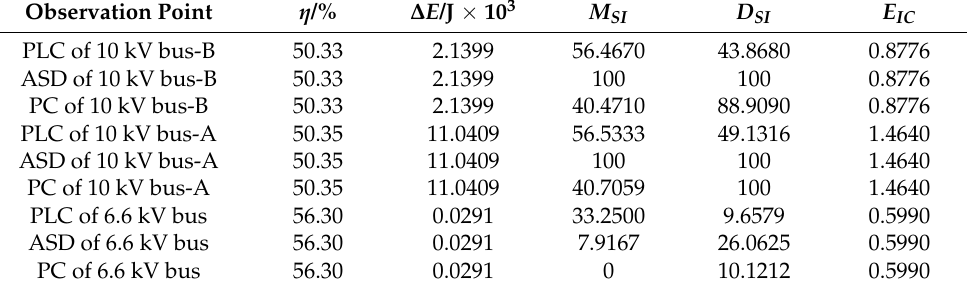
Table 5. Index value of TPSF.